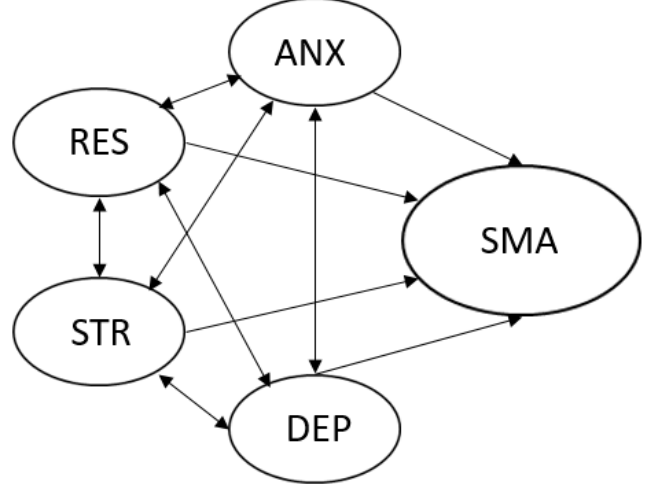
Figure 1. The proposed model of social media addiction (SMA) as a consequence of the interrelationship between resilience (RES), depression symptoms (DEP), anxiety symptoms (AND) and stress symptoms (STR).